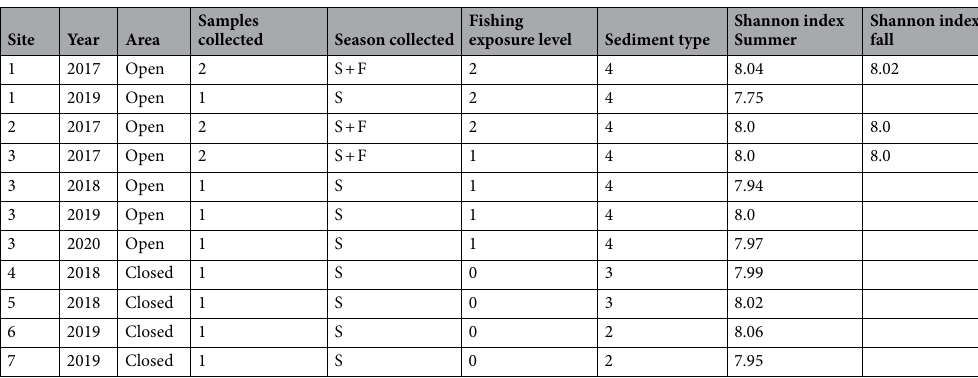
Table 1. Classifications by year and season (S; summer, F; fall) collected, site and the corresponding Shannon H’ Index (Fig. 4a). Fishing exposure level (0_minimal, 1_low, 2_moderate). Sediment type modified from the Barnhardt scale (1_Gravel, 2_Sand_gravel, 3_Sand_mud, 4_Mud_sand) 55 .